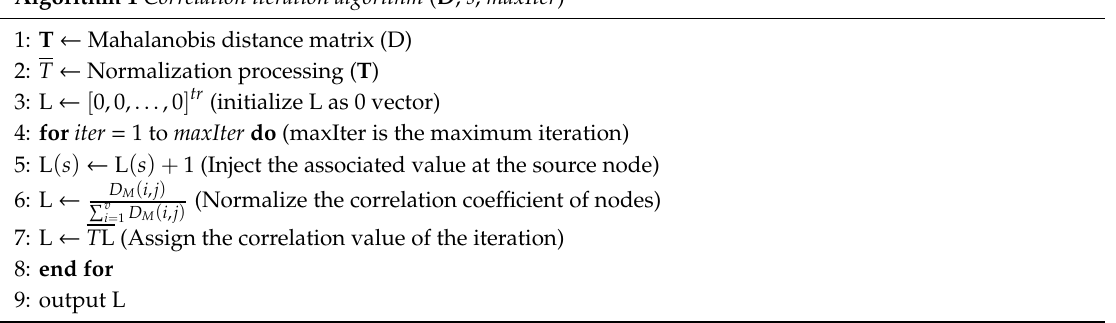
Algorithm 1 Correlation iteration algorithm ( D , s , maxIter